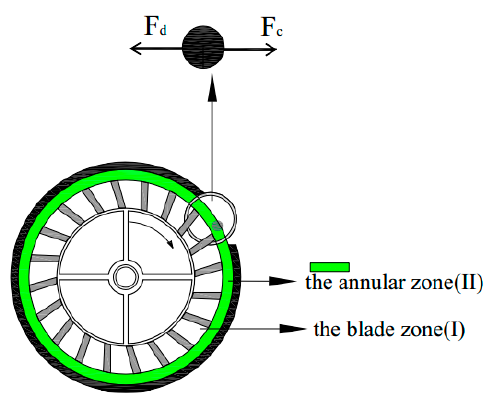
Figure 2. Particle-influencing forces at the inlet of the rotor cage.